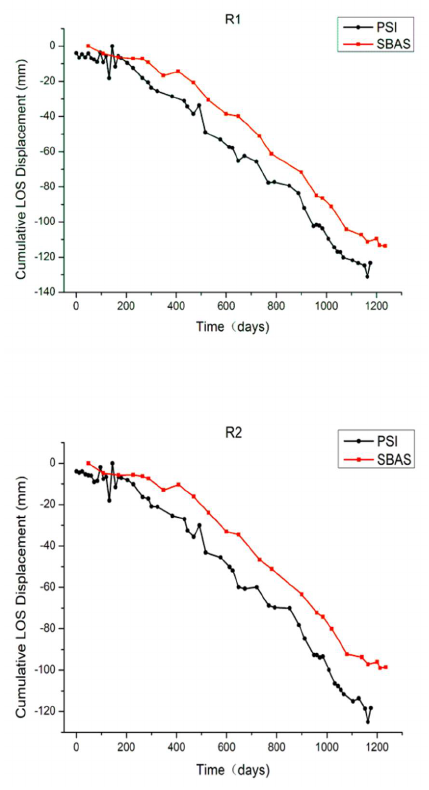
Remote Sens. 2022 , 14 , x FOR PEER REVIEW